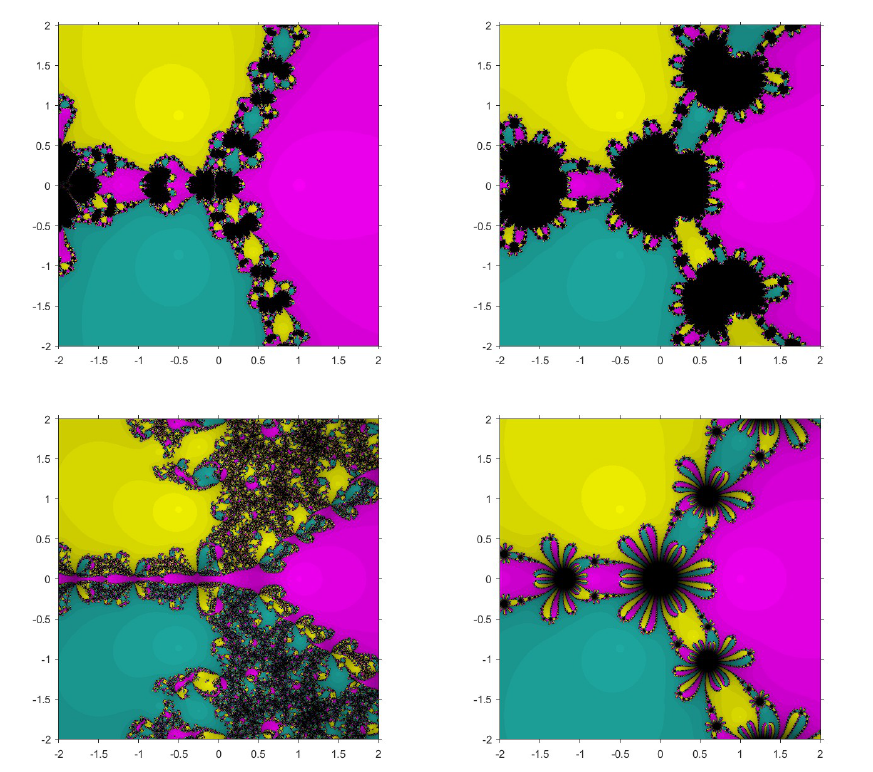
Figure 3. Basins of attraction for PM , SM , AM 1 , and CM , respectively, for p 2 ( z ) .